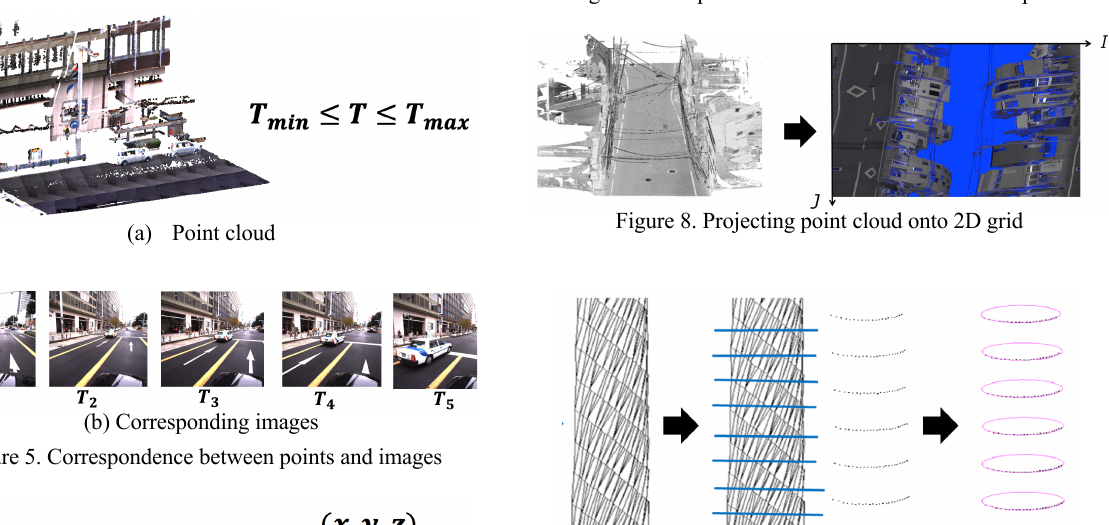
Figure 7. The phase and rotation numbers of each point